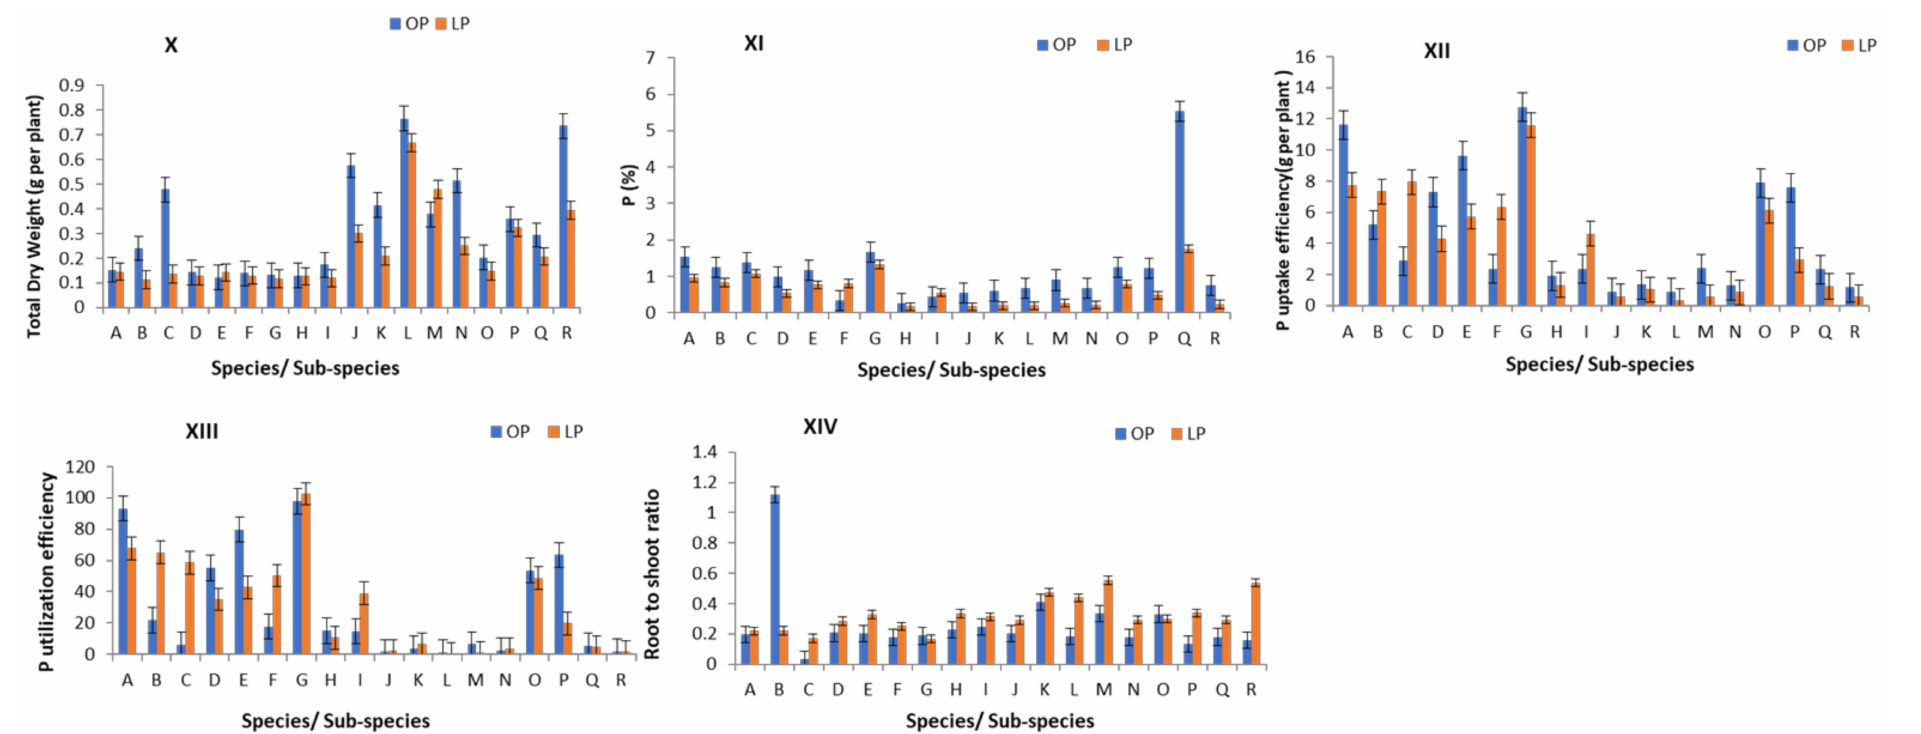
Figure 1. Performance of Vigna spp. under optimum-phosphorus (OP) and low-phosphorus (LP) conditions. ( I ) Primary root length (cm), ( II ) total root length (cm), ( III ) total surface area (cm 2 ), ( IV ) average root diameter (mm), ( V ) total root volume (cm 3 ), ( VI ) total root tips, ( VII ) root forks, ( VIII ) shoot dry weight (g per plant), ( IX ) root dry wight (g per plant), ( X ) total dry weight (g per plant), ( XI ) P (%), ( XII ) P uptake efficiency (g per plant), ( XIII ) P utilization efficiency, ( XIV ) root-to-shoot ratio.(A) Vigna radiata var. bourneae , (B) Vigna pilosa , (C) Vigna minima, (D) Vigna dalzelliana , (E) V. hainiana , (F) Vigna mungo , (G) Vigna mungo var. silvestris, (H) Vigna trilobata , (I) Vigna trinervia var. bourneae , (J) Vigna membranaceae , (K) Vigna umbelleta , (L) Vigna unguiculata , (M) Vigna unguiculata ssp. sesquipedalis ,(N) Vigna racemosa , (O) Vigna radiata var. sublobata , (P) Vigna radiata var. setulosa , (Q) Vigna radiata , (R) Vigna species